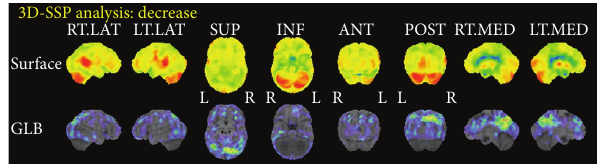
Figure 2: Three-dimensional stereotactic surface projections (3D-SSP) of single-photon emission computed tomography with N-isopropyl[ 123 I]-p-iodoamphetamine (IMP-SPECT) of Case A. Marked decrease of blood flow at precuneus and posterior cingulate cortex were observed, which suggested the diagnosis of comorbid Alzheimer’s disease.